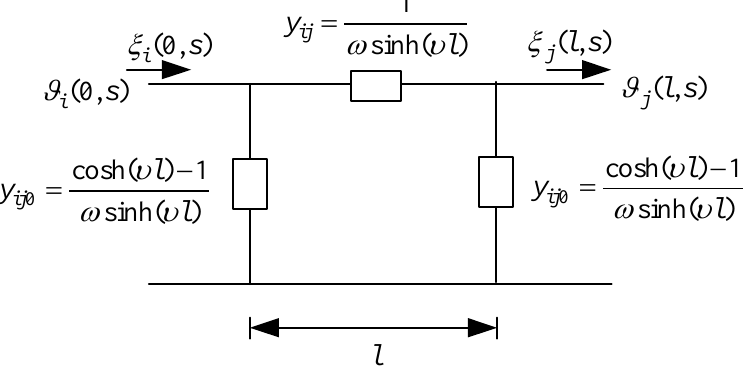
Figure 3. π -Type equivalent circuit of the IES.